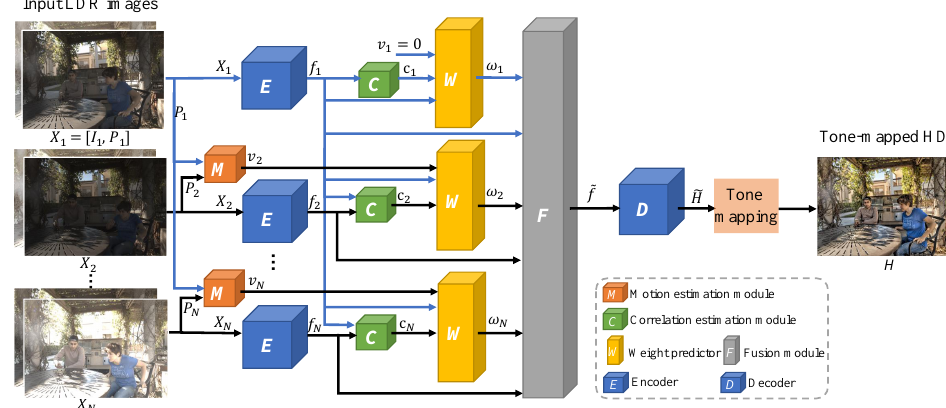
Figure 1. The framework of proposed